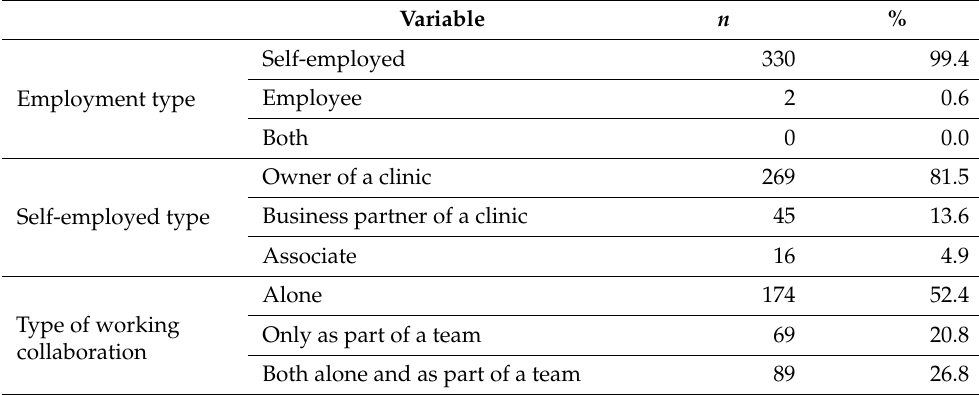
Table 2. Distribution of work situations ( n =